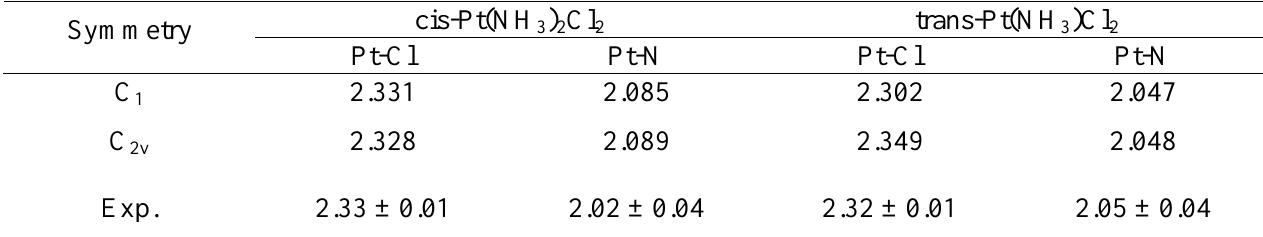
Table 1. Ab initio calculated and experimental [17] Pt-Cl and Pt-N bond lengths [Å] for cis and trans